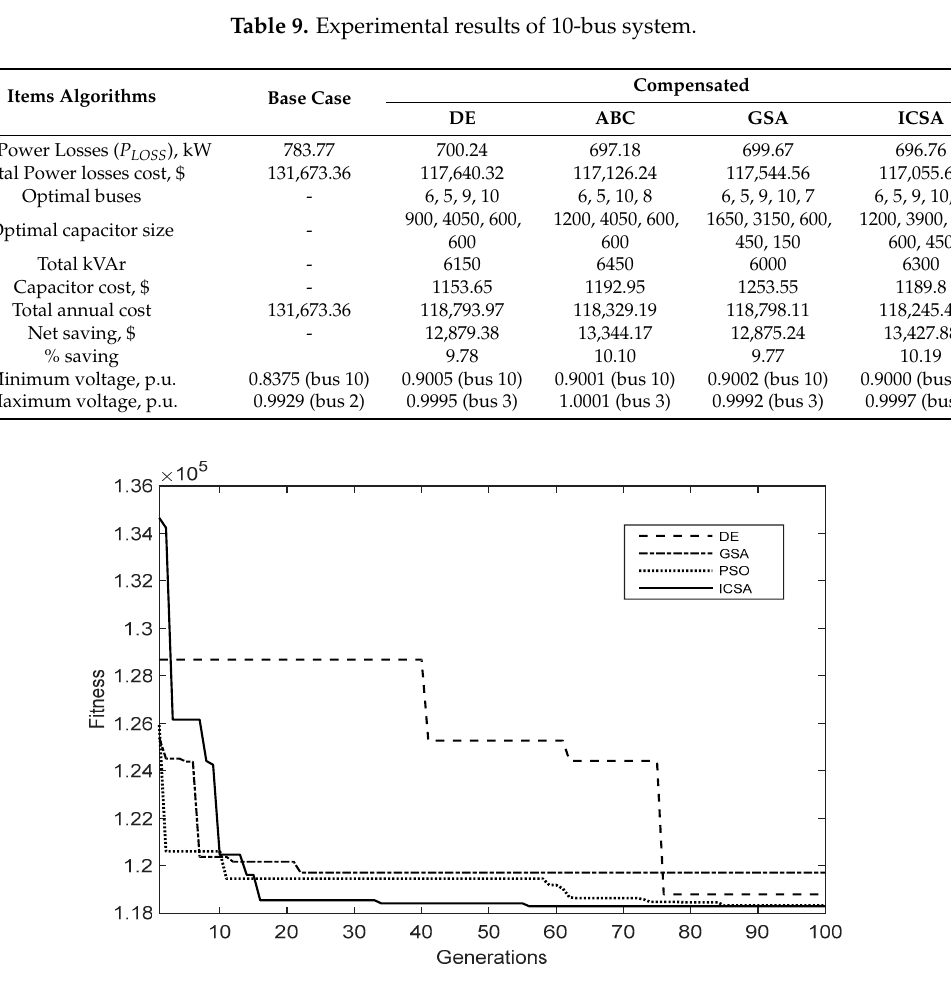
Figure 8. Convergence comparison 10-bus.